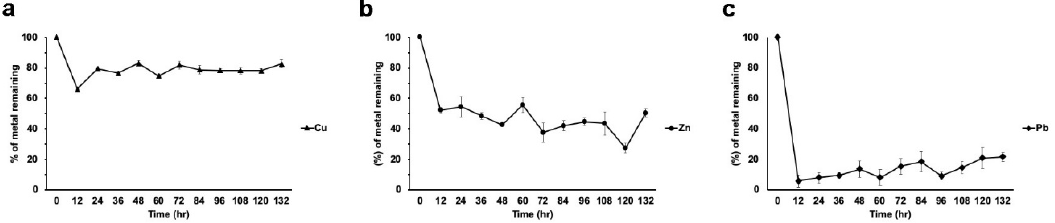
Figure 5. Metal removal from liquid cultures by strain H17. ( a ) Copper, ( b ) zinc, ( c ) lead. All treatments were tested in triplicate. Data is presented as the average amount of metal remaining in the media (%) ± standard deviation (error